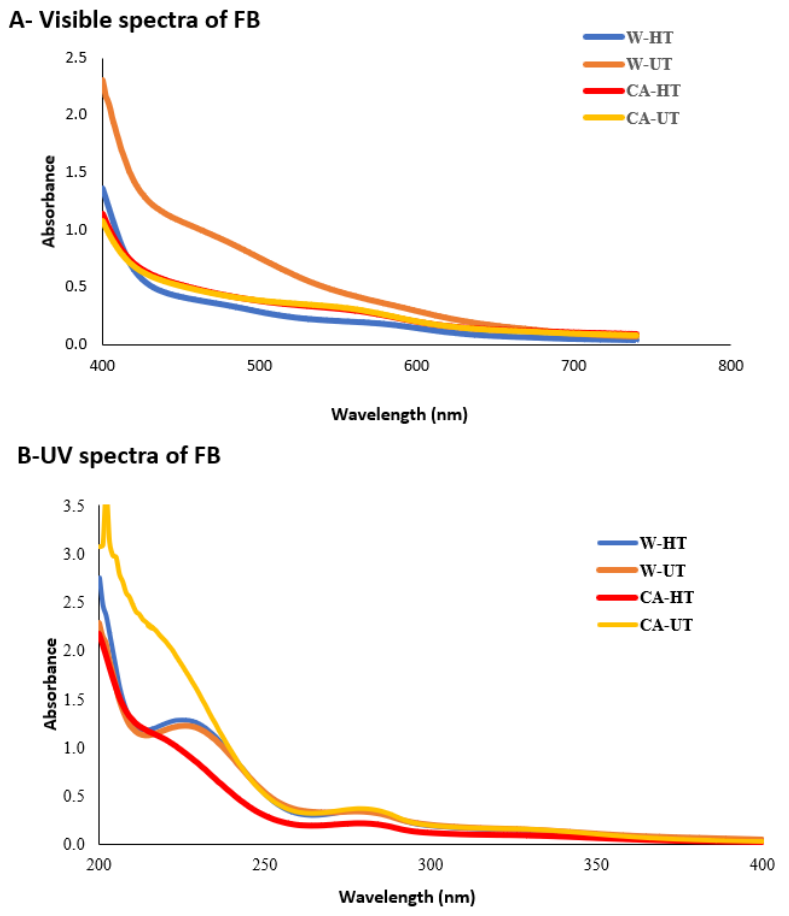
Figure 2. Visible ( A ) and UV ( B ) spectra of functional beverages.